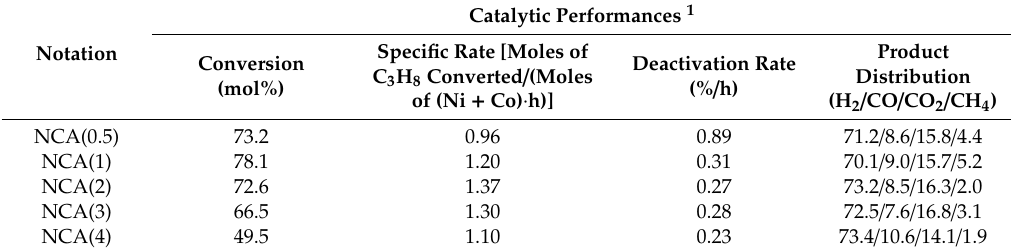
Table 2. Summarized results of the catalytic performances on the NCA